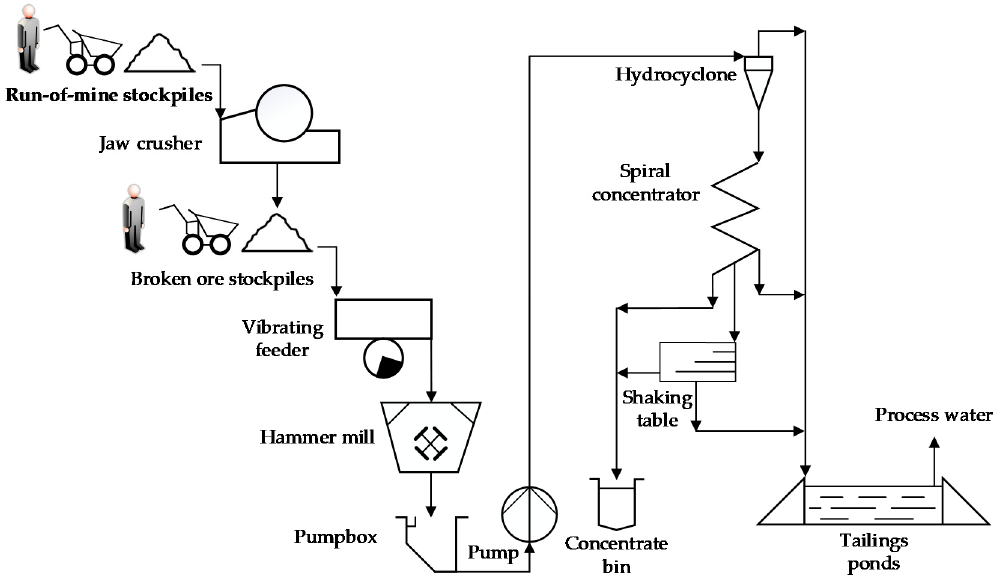
Figure 1. Flowchart diagram of small-scale processing plant.